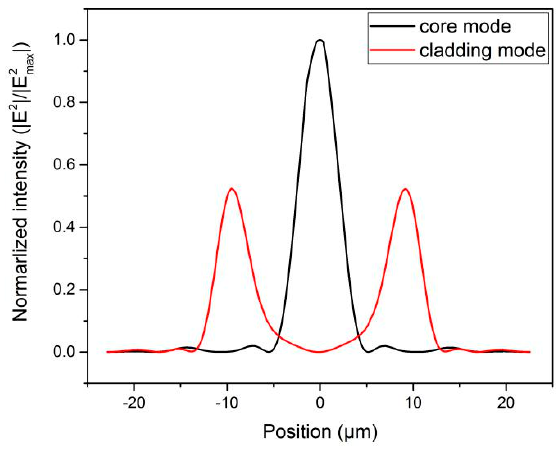
Figure 5. The normalized intensity in the MOF at 1550 nm.